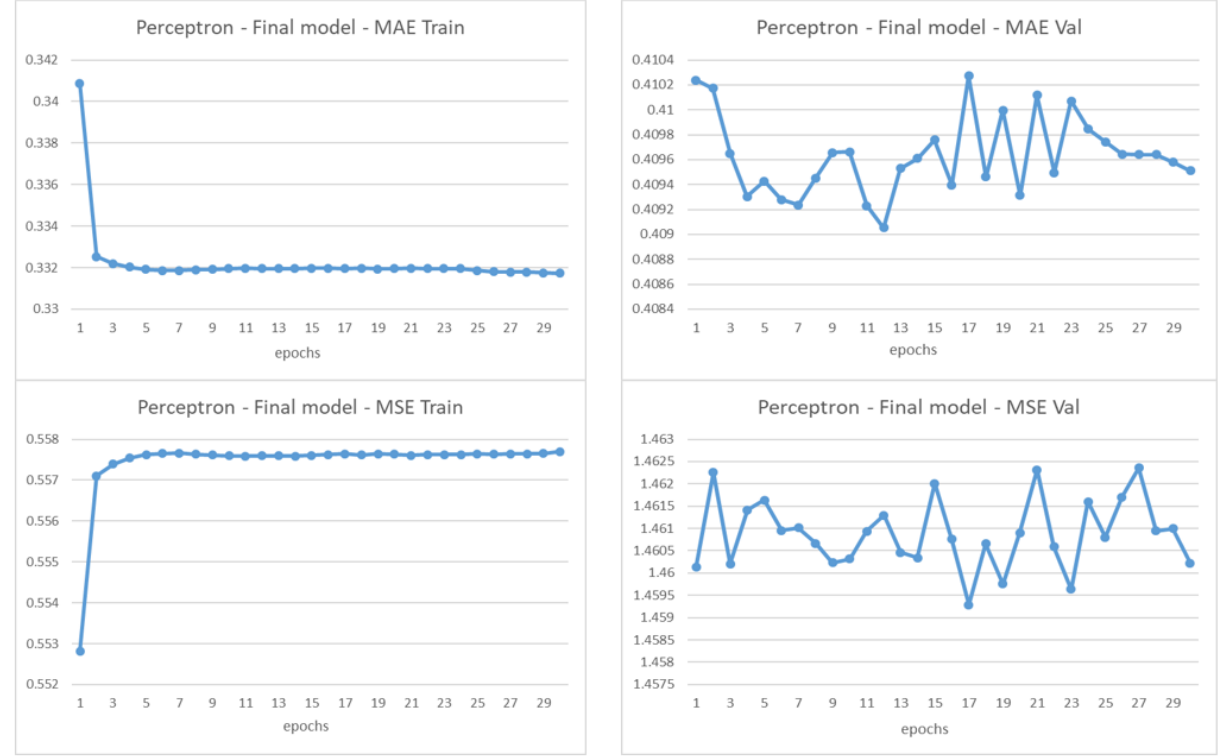
Figure 15. Source: Metrics resulting from the final trained model, Own elaboration.